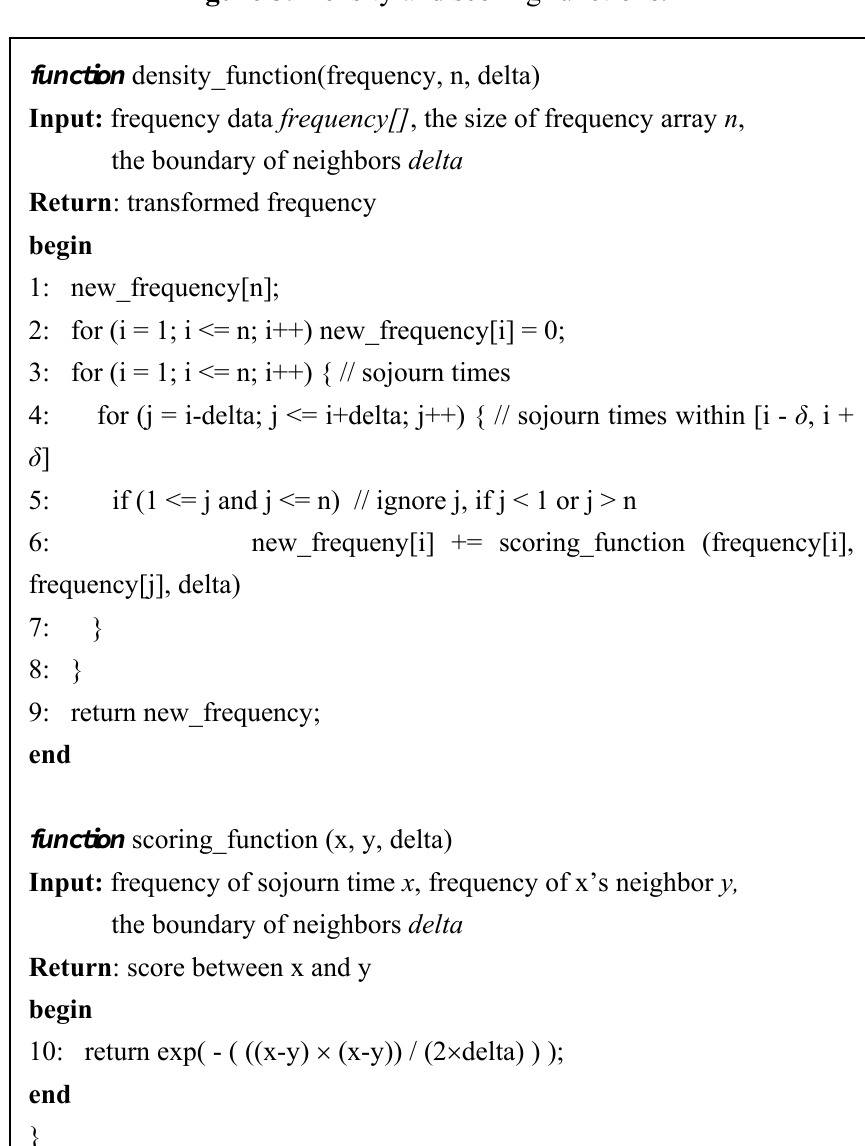
Figure 5. Density and scoring